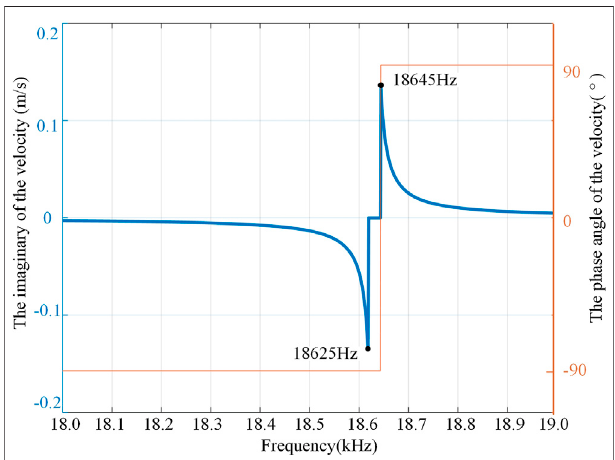
FIGURE 11 | The vibration velocity of the